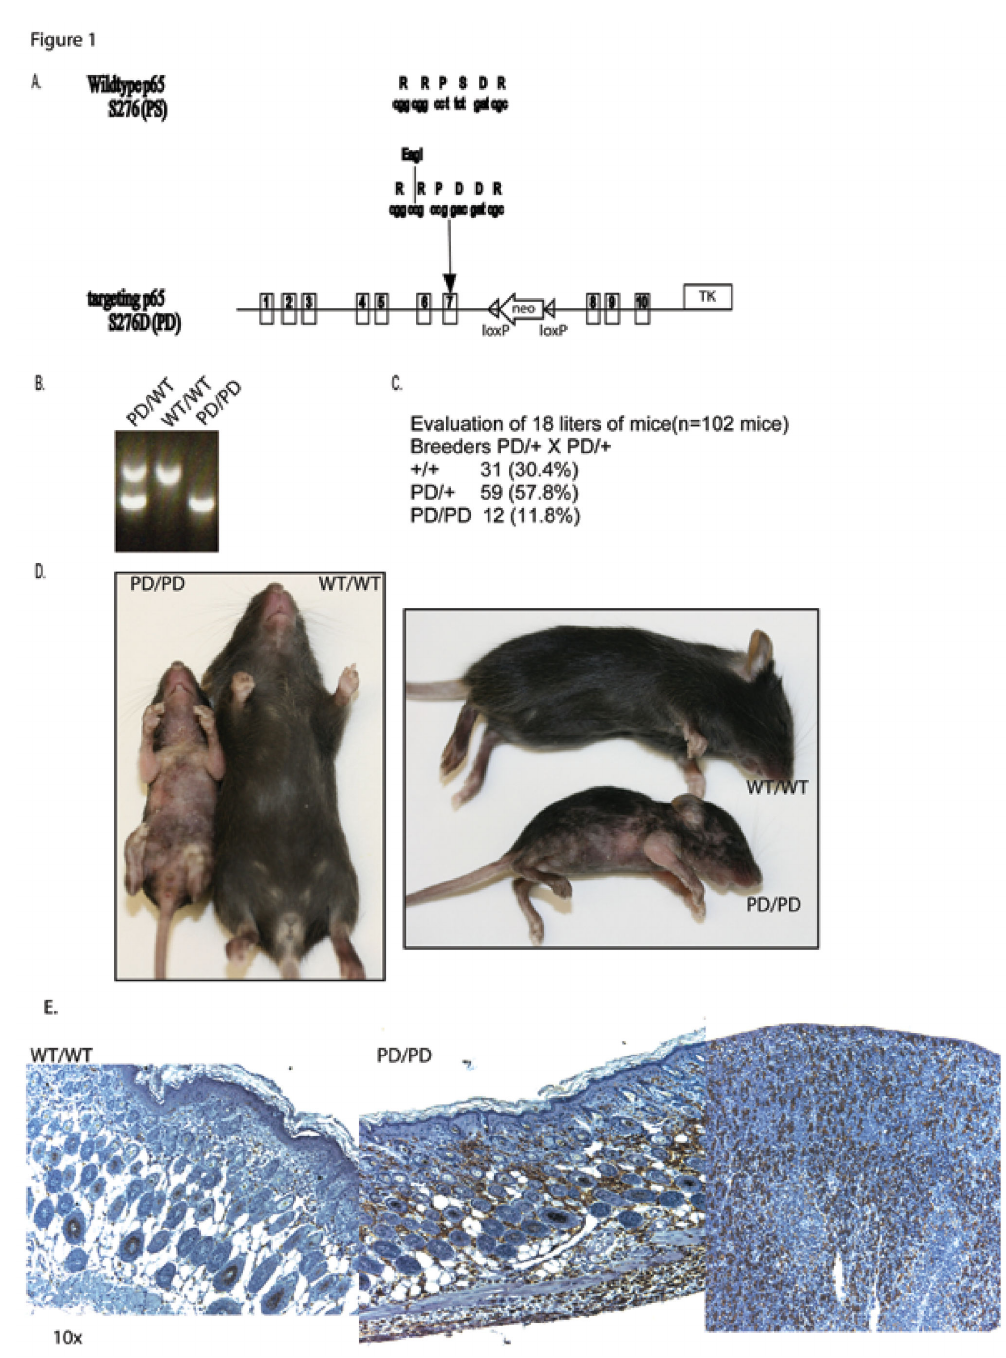
Figure 1. Generation of PD mice. Targeted knock-in at RelA to generate a S276D amino acid transition from exon 7 in mice creating the PD targeting vector. A. Strategy for generating the targeted knock-in including the coding change at serine 276 and addition of an EagI restriction site to allow for genotyping. B. Genotyping of the PD mouse shows a 722 base pair (bp) cDNA in the wild-type mouse that can be cut in to two pieces (356 and 366 bp) with EagI in the presence of the PD allele. C. Homozygous PD mice are born in fewer numbers than expected by normal Mendelian ratios. C. Approximately 10 day old littermates from a male and female heterozygous PD breeding. Homozygous PD mice are runted, erythrodermic, alopecic, and scaly. At this point in development, wild-type littermates demonstrate normal hair growth and size. D. Immunohistochemistry staining of mouse skin showing few F4/80+ cells in wild-type tissue (left) compared to the large infiltrate in PD homozygous mouse skin (middle). Spleen shows typical F4/80+ staining as a control (right). doi: 10.1371/journal.pone.0071887.g001 PLOS ONE |